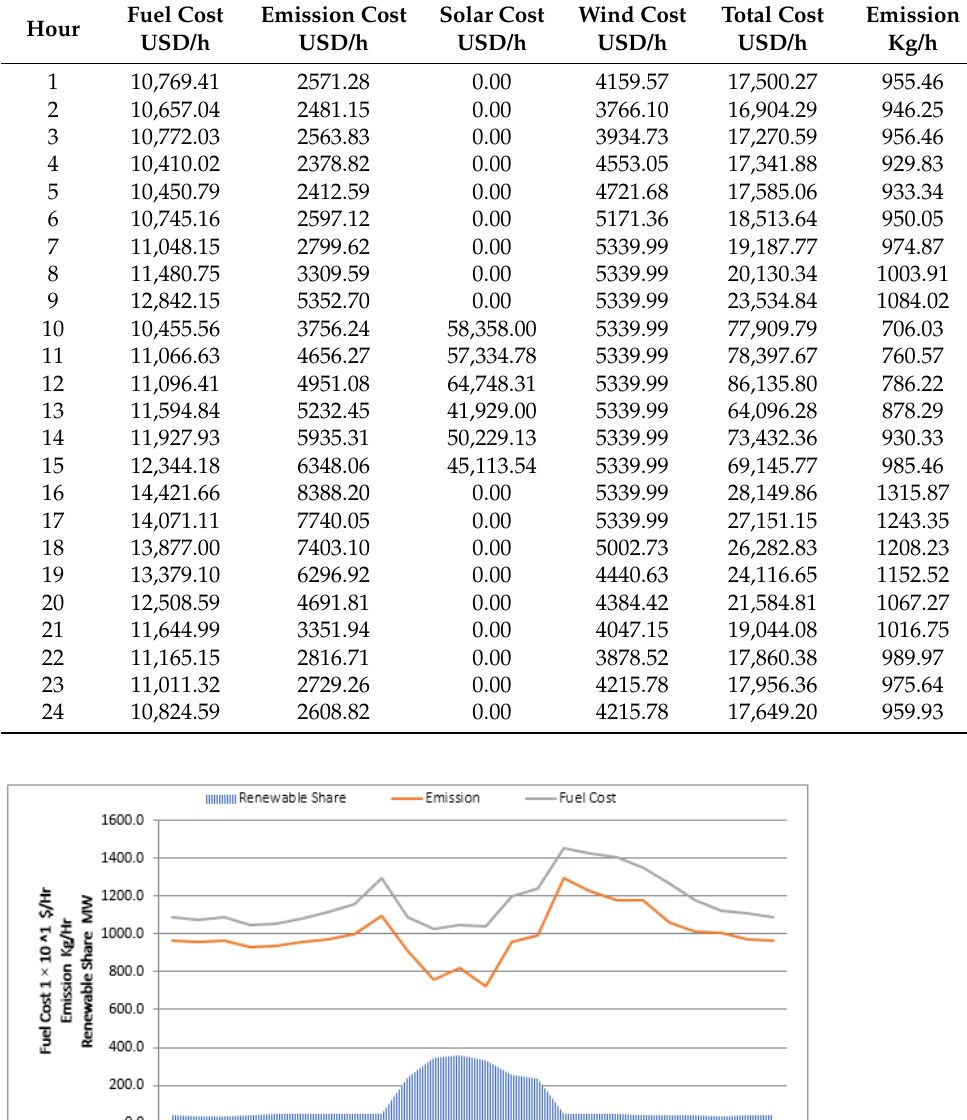
Table 16 and Figure 9 present the cost and emission values for 24 h in case study 2. Table 16. Table of costs and emissions for 24 h—case study 2.